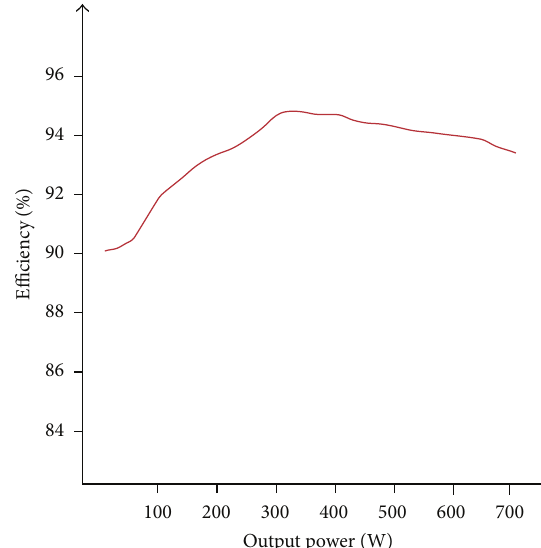
Figure 26: The measured efficiency of the proposed MIC.